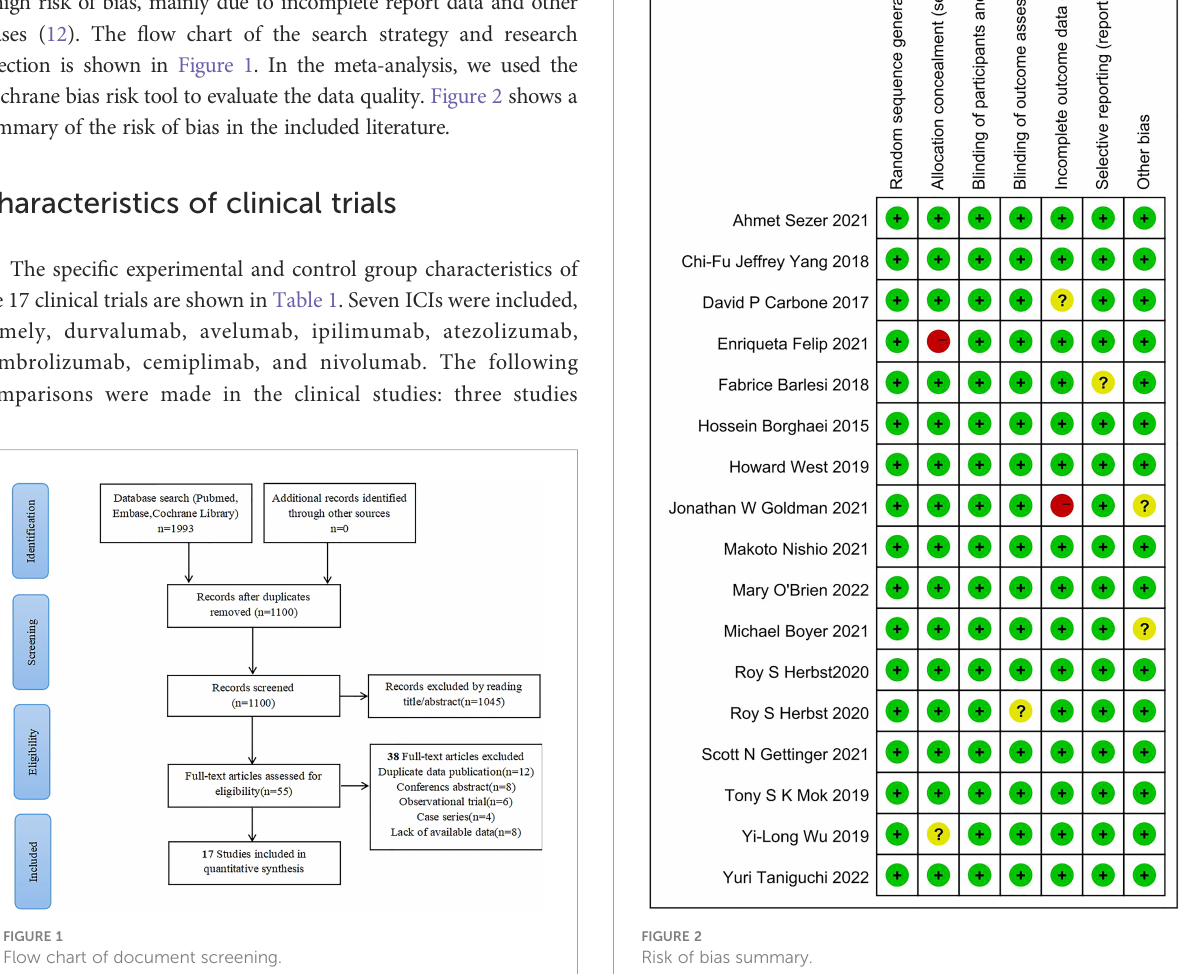
FIGURE 2 Risk of bias